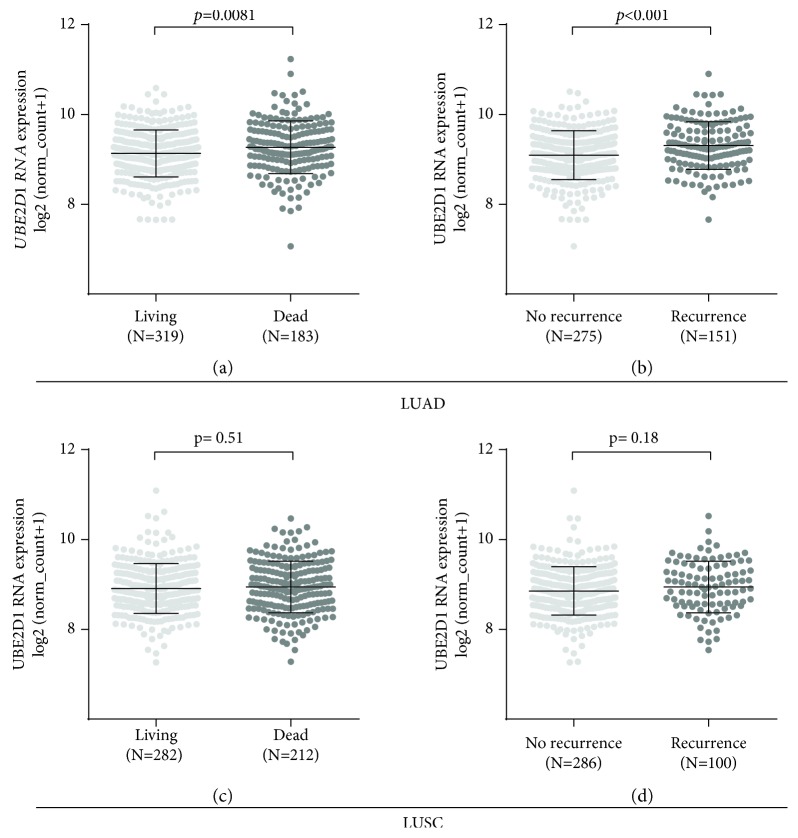
Comparison of UBE2D1 RNA expression in LUAD/LUSC patients with different survival outcomes (a–d). Comparison of UBE2D1 RNA expression in LUAD (a–b) and LUSC (c–d) patients according to their living status (a, c) and recurrence status (b, d).